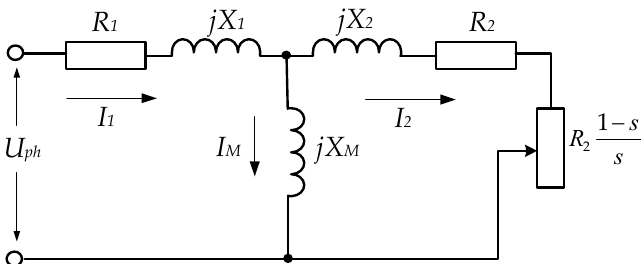
Figure 2. T-type reduced to one-phase equivalent circuit of AC induction motor ( R 1 , R 2 —equivalent resistance of stator and rotor; X 1 , X 2 —equivalent reactance of leakage flux in stator and rotor windings, X M —the reactance of magnetizing flux in AC motor; U Ph —supply phase voltage; I 1 , I 2 , I M —primary, secondary, and magnetizing currents in stator and rotor windings).